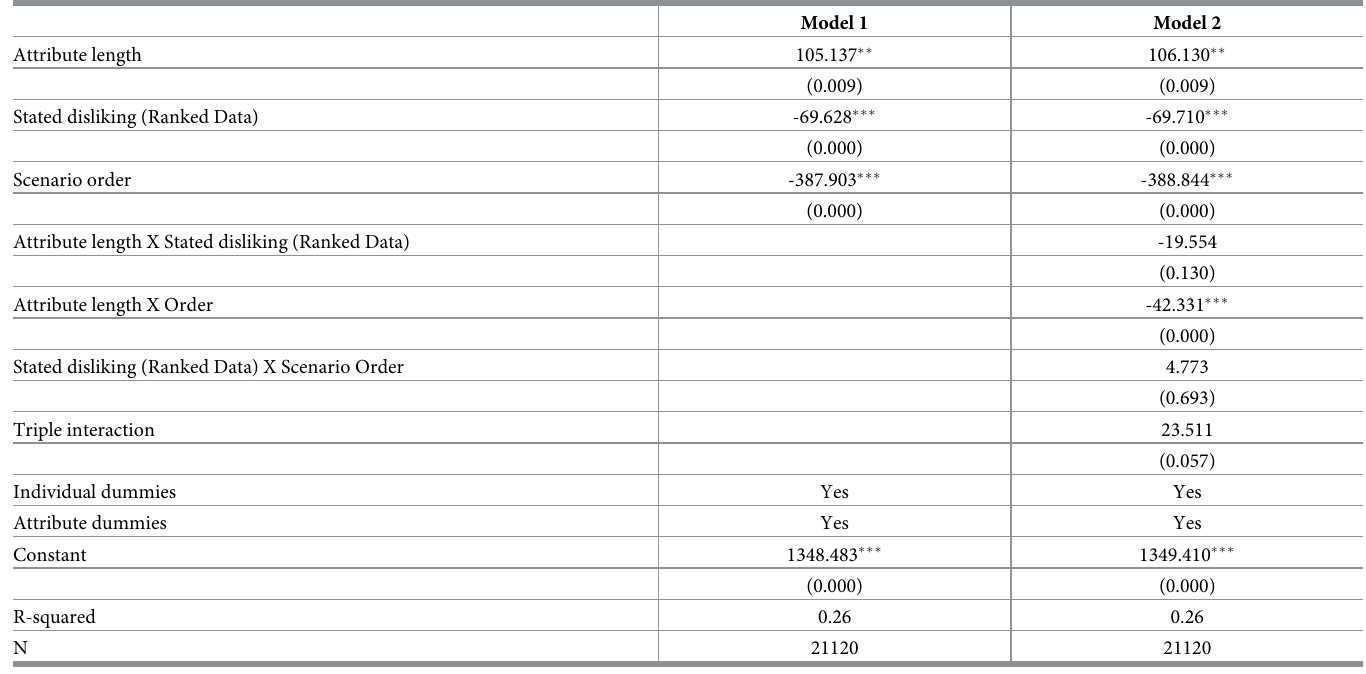
Table 4. Triple interaction regression table. Regression models of the relative impact of attribute length, individual ranking, and scenarios order on the time spent on attributes and corresponding degrees (p-values within parentheses). The three explanatory variables are